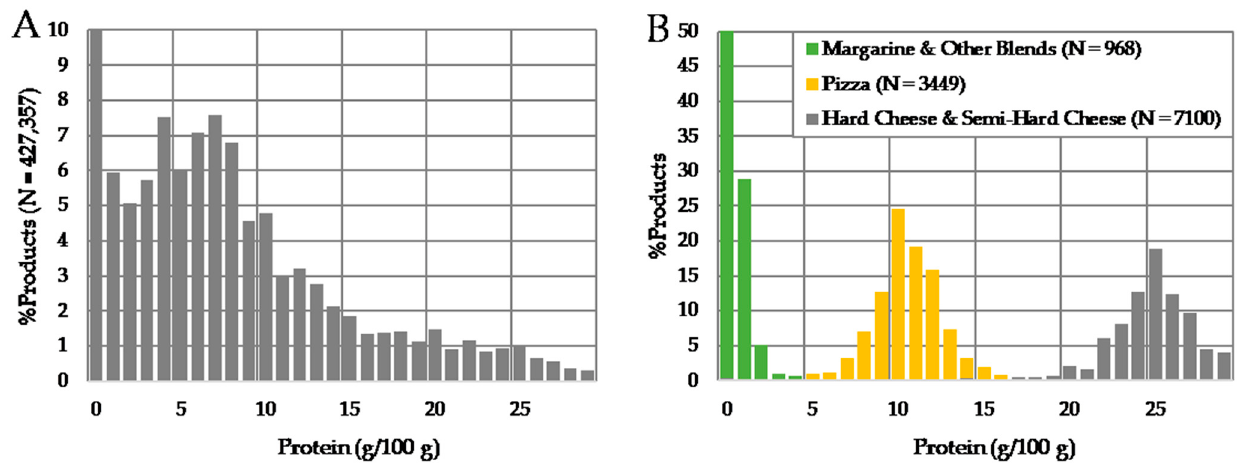
Figure 1. Relative distribution of protein among all N = 427,357 products featuring a protein content (A) and among three selected categories: Margarine and Other Blends (N = 968), Pizza (N = 3449) and Hard Cheese and Semi-Hard Cheese (N = 7100) (B).